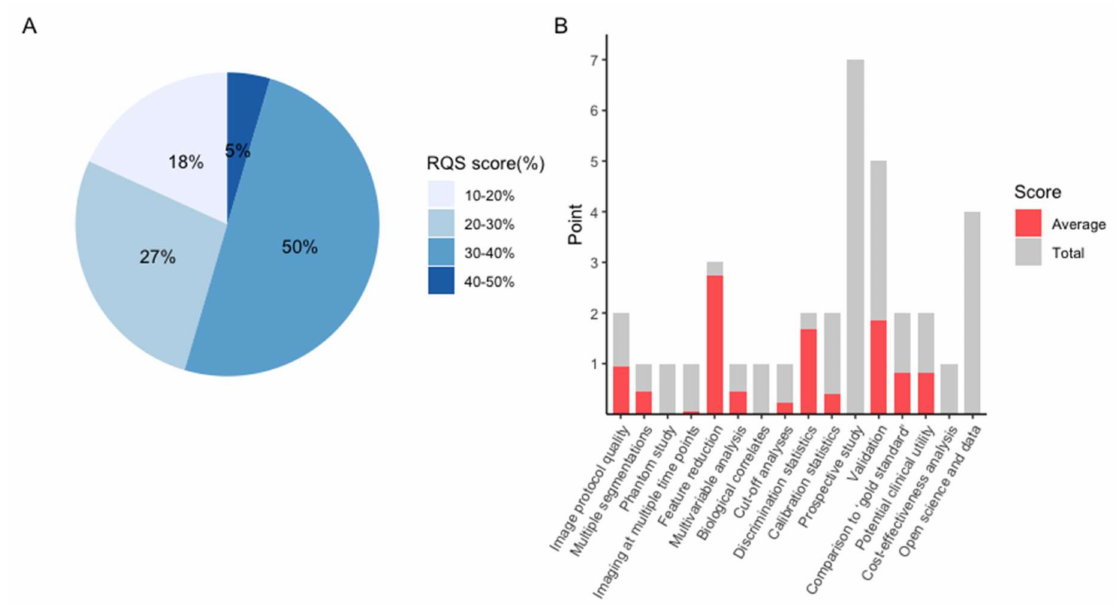
Figure 3. Methodological quality evaluated by using the Radiomics Quality Score (RQS) tool. ( A ). Proportion of studies with different RQS percentage score. ( B ). Average scores of each RQS item (gray bars stand for the full points of each item, and red bars show actual points).